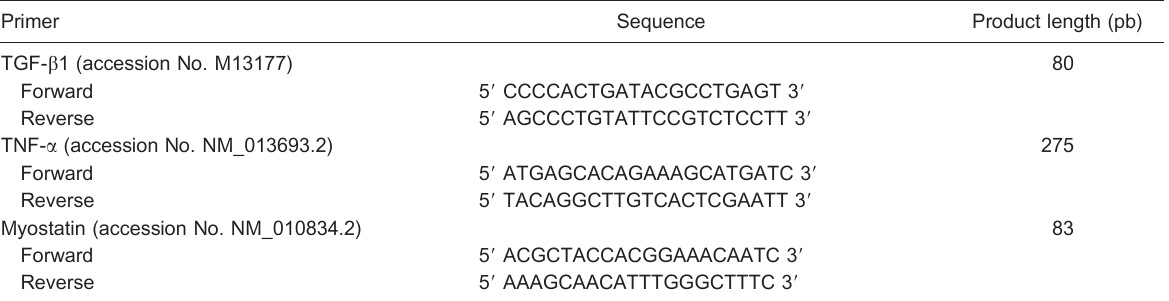
Table 1. Forward and reverse primers for quantitative real time PCR